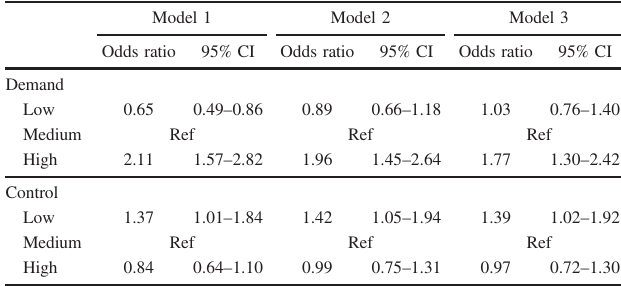
Table 2. Odds ratios (95% con fi dence intervals) of being aggravation of pre-existing diseases with demand and control